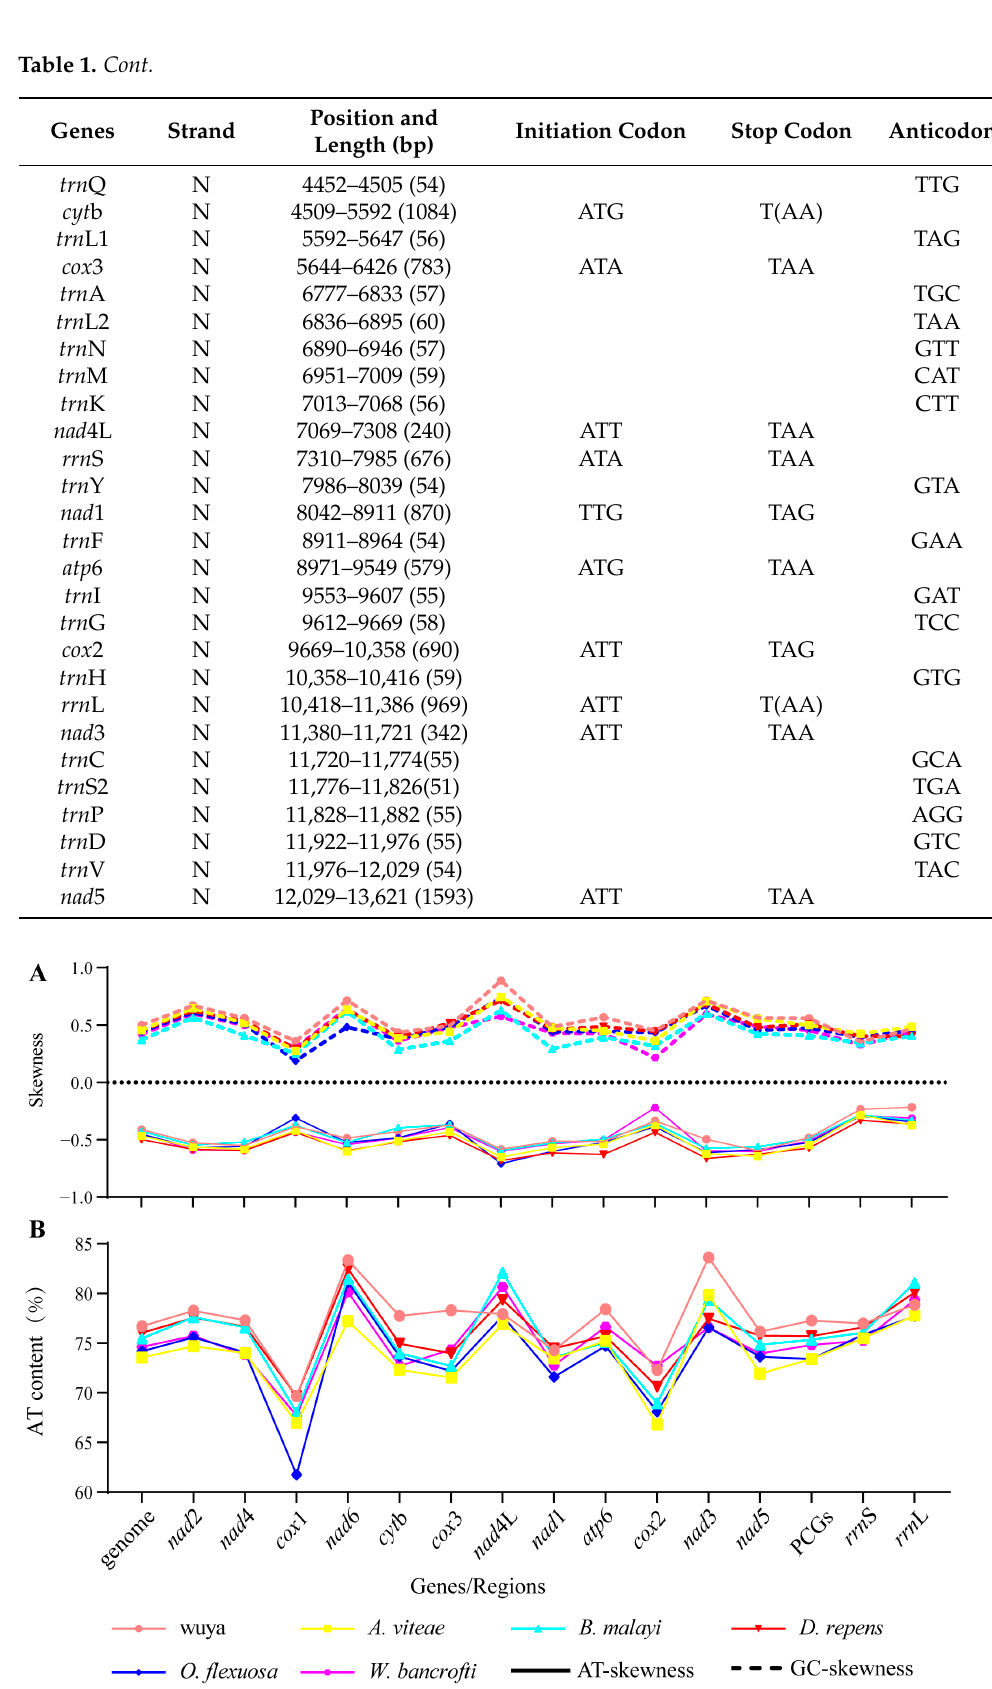
Figure 2. AT/GC contents and AT/GC skews of the investigated mitogenomes. ( A ) AT GC skews. ( B ) AT contents (%).